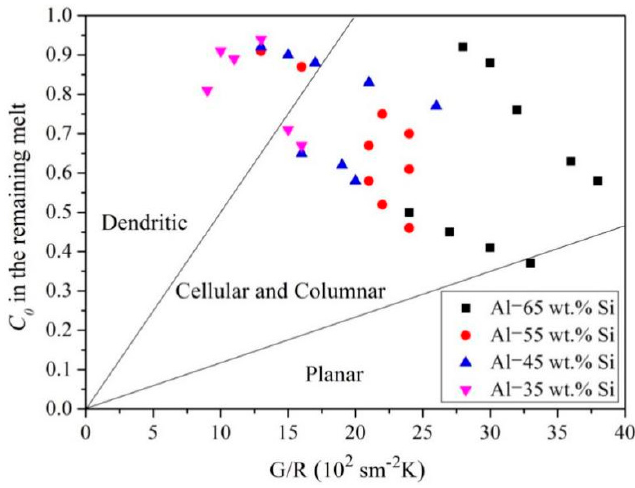
Figure 11. Predominance area diagram for Si morphological evolution.